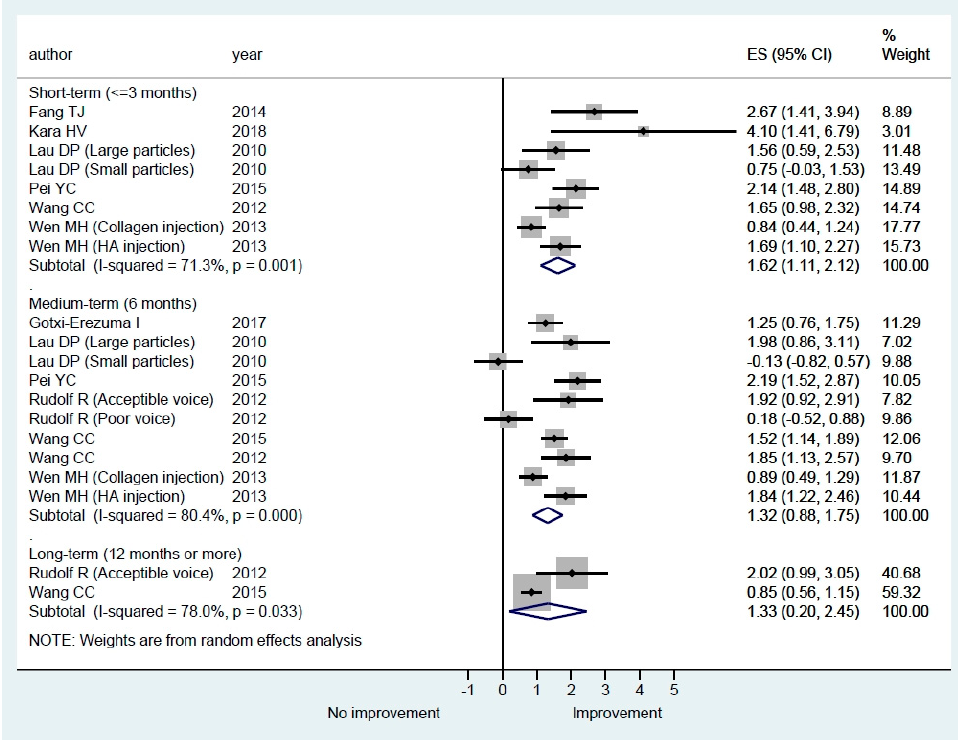
Figure 2. Subgroup meta-analysis of overall quality of life in short-term, medium-term, and long-term follow-up after hyaluronic acid injection laryngoplasty.